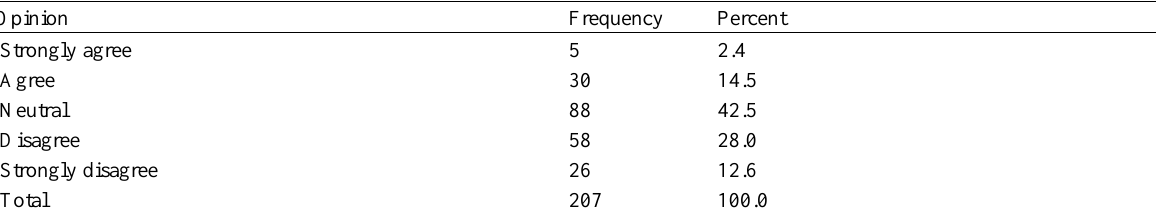
Table 9: Joint Ownership of Challenges and Success of among the